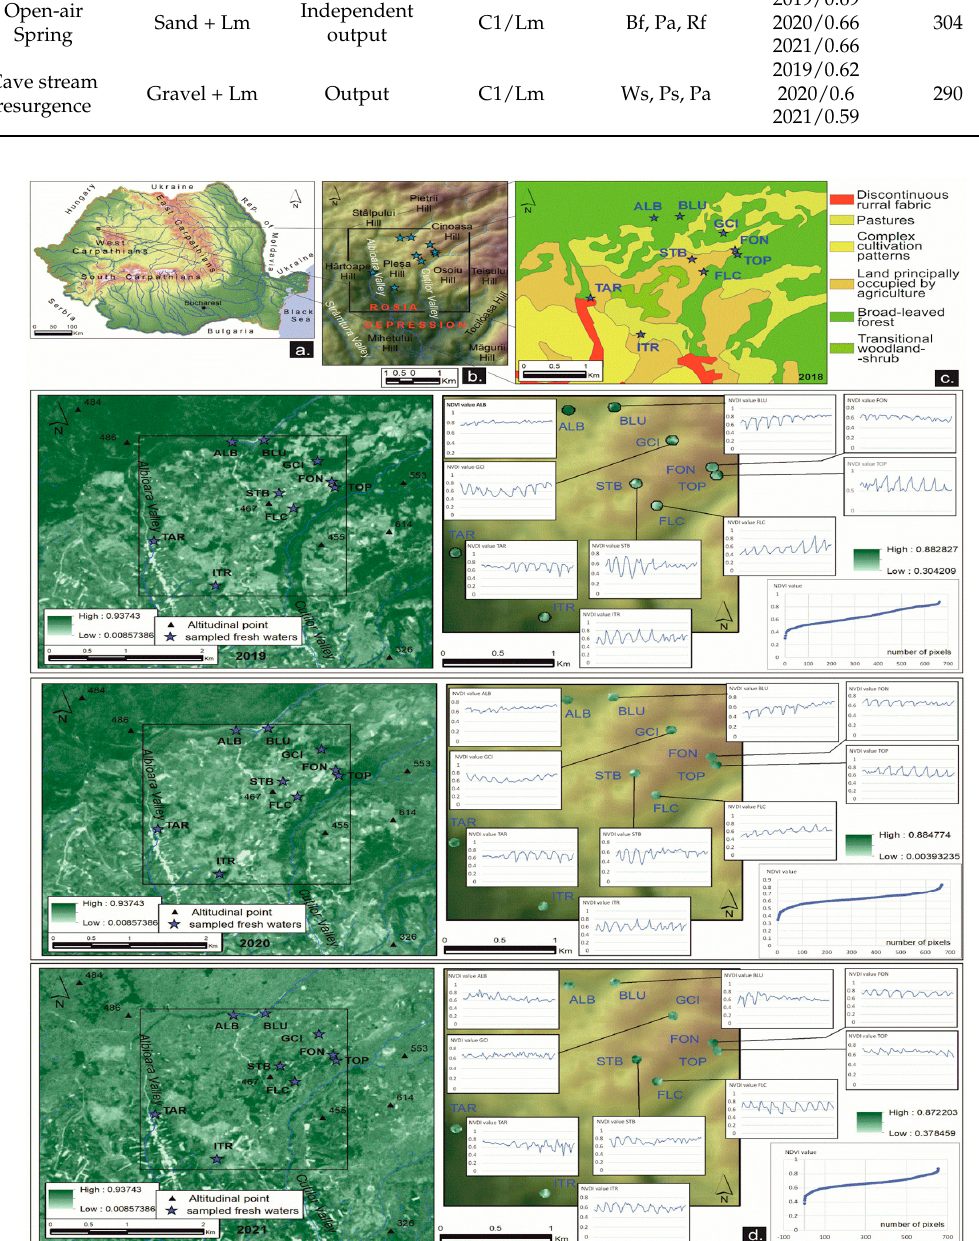
Figure 1. Map of the karst system of Runcuri Plateau (KSRP) and adjacent areas with emphasis on: ( a , b ) location of sampling sites; ( c ) land use, and ( d ) normalized difference vegetation index (NDVI) within the area of interest.